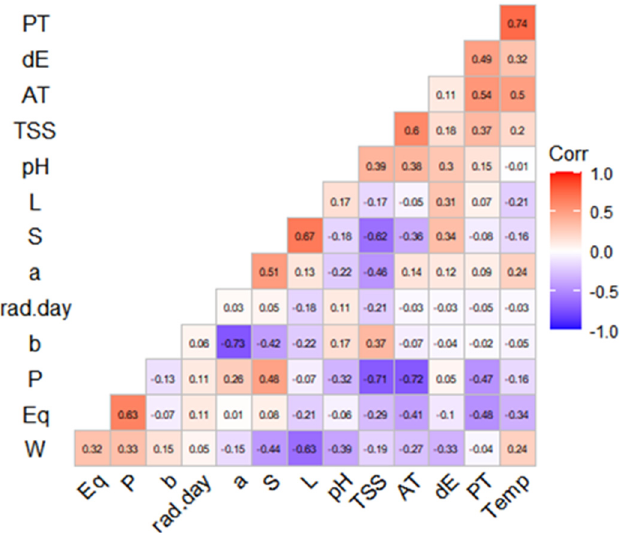
Figure 2. Matrix of correlation between UV solar radiation and temperature with physicochemical parameters of calafate berries. PT, polyphenols, dE, color differential ( Δ E); AT, sum of individual anthocyanins; TSS, total soluble solids; pH, potential of Hydrogen; L, luminosity ( CIEL*a*b* ); S, period of time (2017, 2018, 2019); a and b, chroma in CIE L*a*b* components, P, polar diameter; Eq, equatorial diameter; W, weight; Temp, temperature; rad.day, maximum radiation per day.